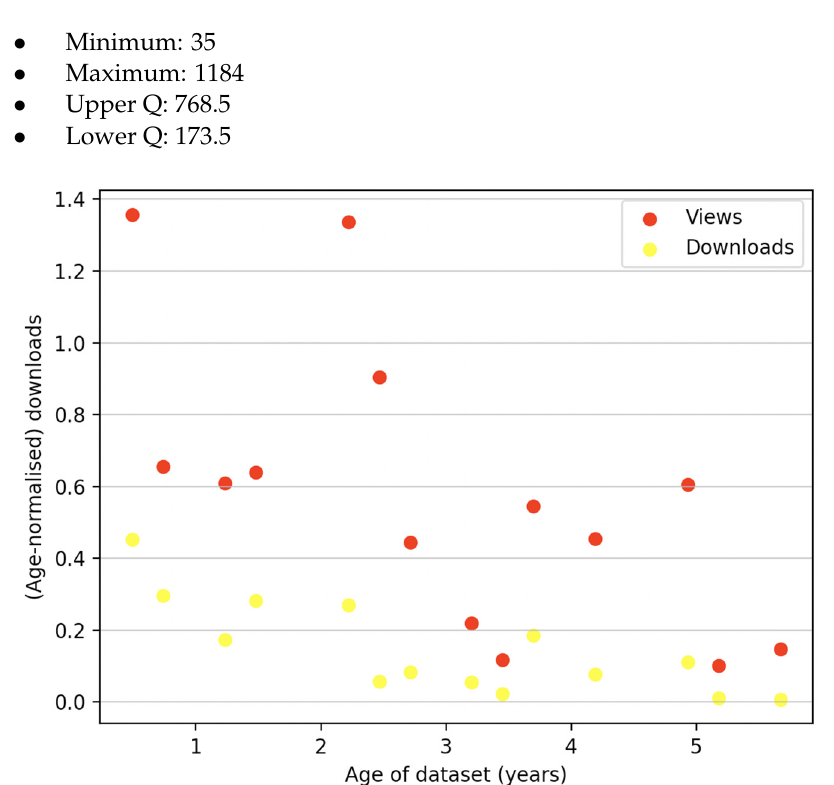
Figure A11. Datasets associated with JOHD/RDJ data papers: average total downloads and views over time (3-month ranges).